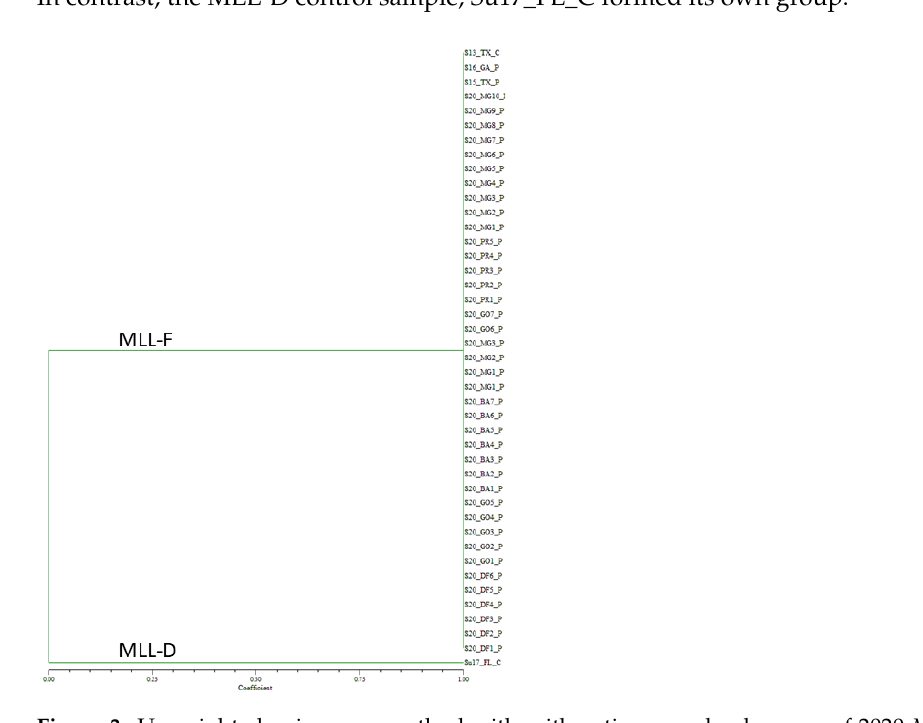
Figure 2. Unweighted pair group method with arithmetic mean dendrogram of 2020 Melanaphis spp. samples collected on giant miscanthus, sorghum, and Johnsongrass from 13 United States cities and genotyped using nine simple sequence repeat markers. Sipha flava was used as an outgroup. All the Melanaphis samples collected in the United States in 2020 were found to be MLL-F ( Melanaphis sorghi ). MLL, multilocus lineage.